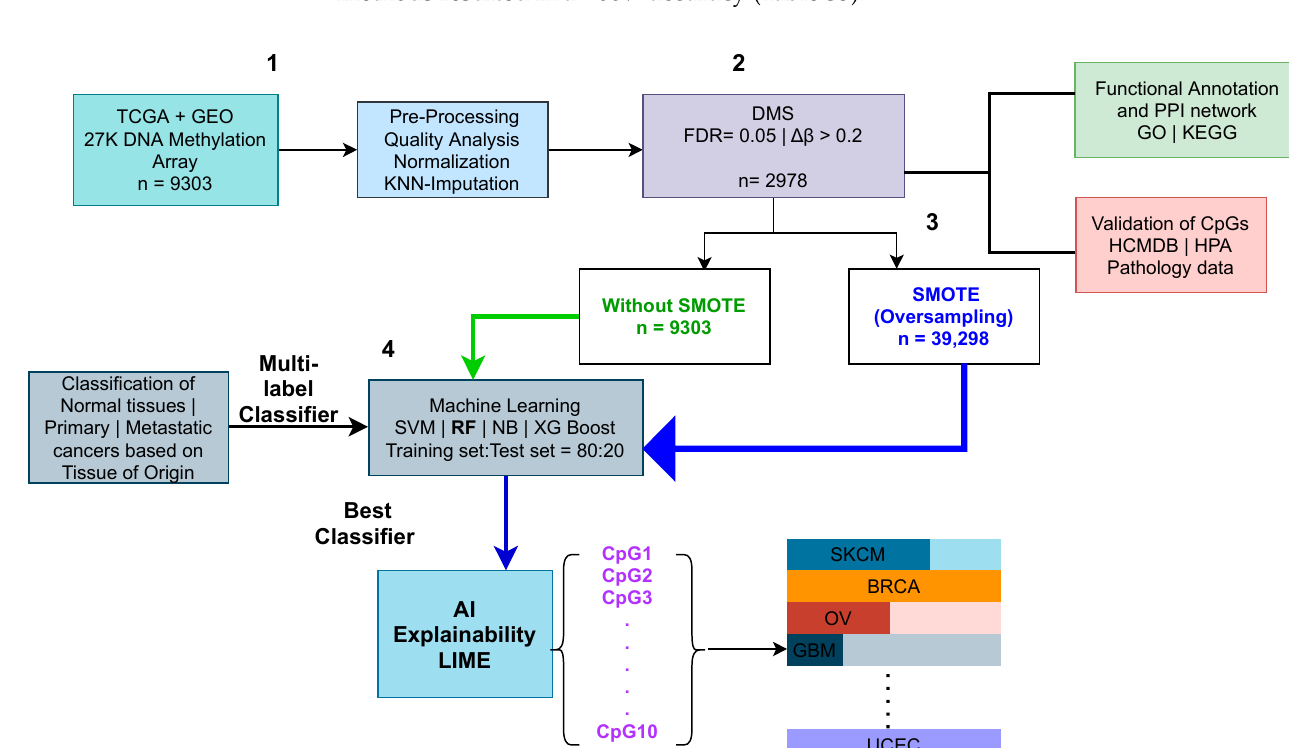
Figure 2. Schematic representation of analysis presented in the study. The overall workflow is divided into four components: ( 1 ) data acquisition, preprocessing, and quality control analysis; ( 2 ) defining prediction biomarkers for the classification using DMS analysis; ( 3 ) evaluation of predictive biomarkers using GO, KEGG, and PPI analysis; and ( 4 ) applying machine learning models and interpreting the decision of the classifier using LIME. A total of 9303 methylome samples were download from TCGA and GEO. The samples were preprocessed and normalized, and missing values were imputed using the KNN method. Further, DMS analysis was performed to define prediction biomarkers. The biomarkers were evaluated using GO, KEGG, and PPI analysis and further compared with the HCMBD and HPA pathology databases. A multi-label ML classification model was built for classifying normal tissues, and primary and metastatic cancer types based on tissue of origin, before and after applying SMOTE. LIME was applied to the best-performing model to interpret the prediction model for every class.